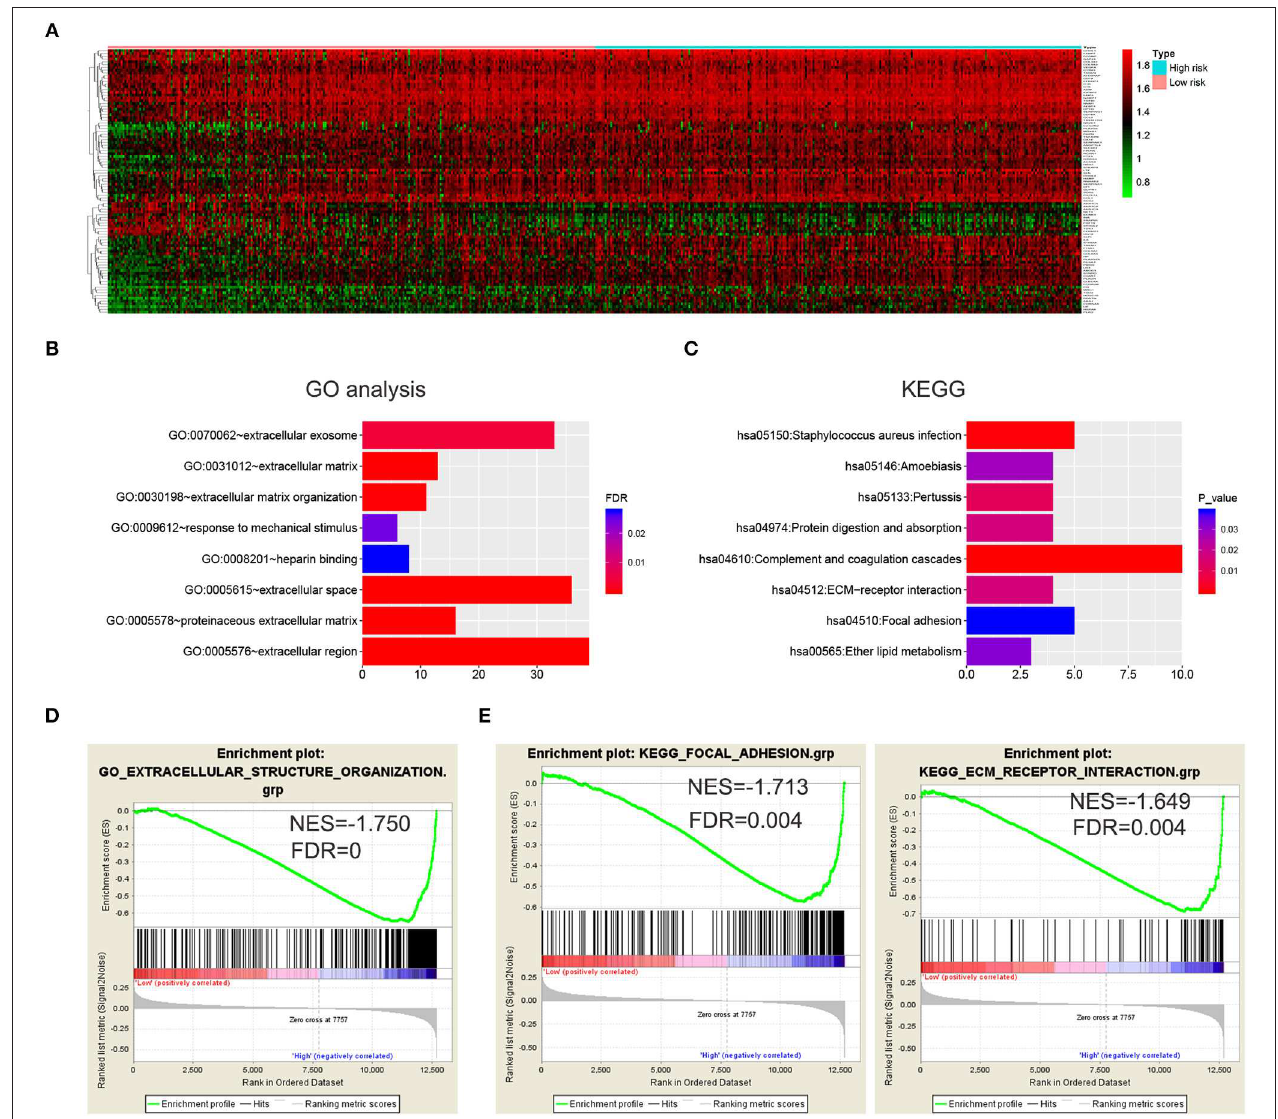
FIGURE 4 | Biological functions and KEGG pathways related to the risk signature with five genes. (A) Heatmap showed the DEGs between the high-risk group and the low-risk group (FDR < 0.05). GO analysis (B) and KEGG pathway analysis (C) via DAVID based on the DEGs. (D,E) GSEA was performed to confirm the GO term (extracellular structure organization) and KEGG pathways (ECM receptor interaction and focal